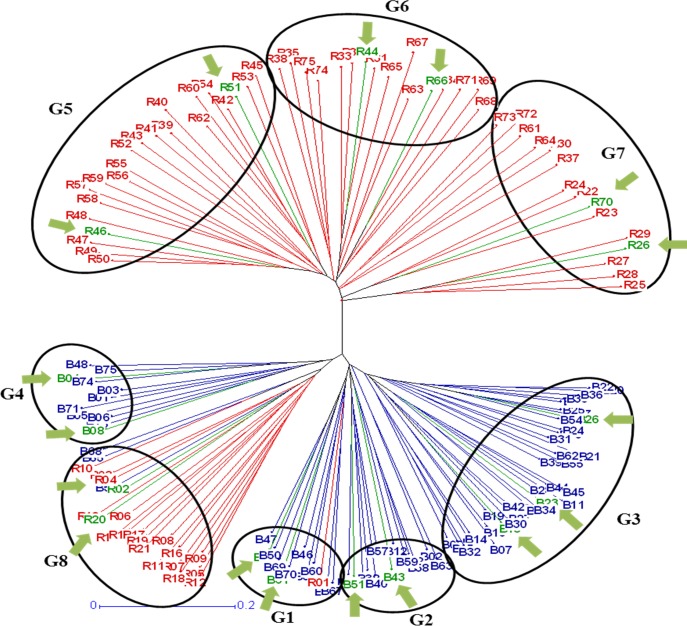
Clustering of 147 hybrid parents into 8 groups using SSRs, and selection of representative 17 parents from different marker based groups (as shown by arrow mark).